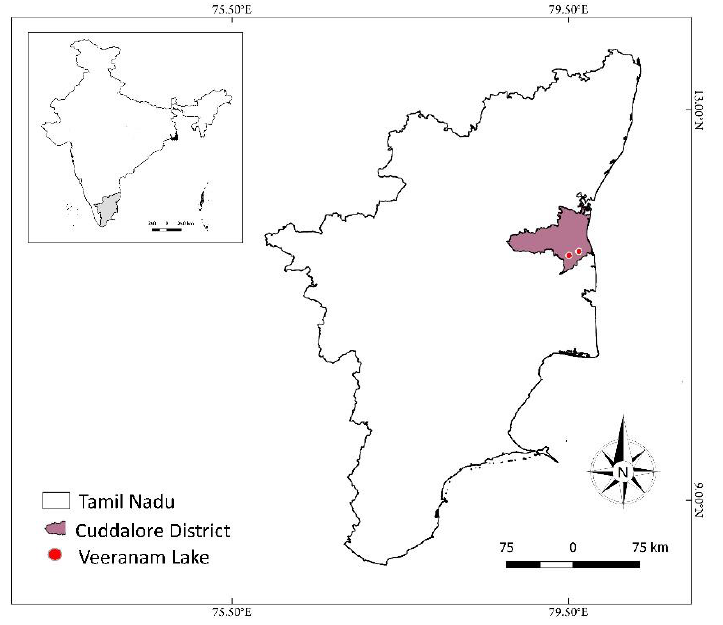
Figure 1. Map showing the location of Veeranam freshwater Lake, Tamil Nadu, India.